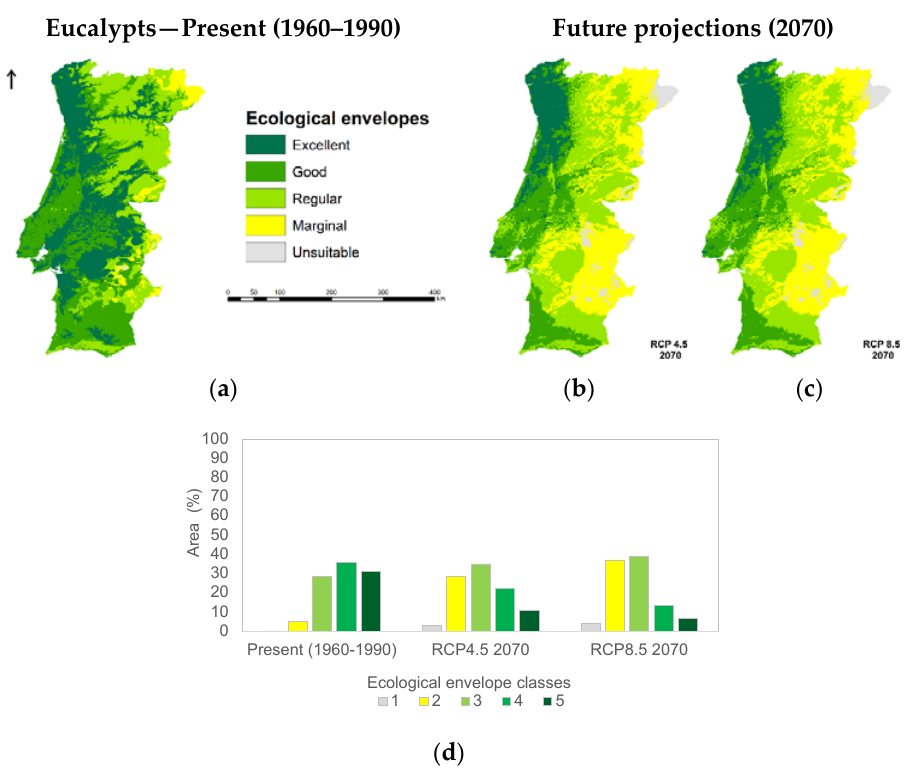
Figure A1. Species ecological envelopes: ( a ) Present (1960–1990); ( b ) Future RCP4.5 scenarios for 2070; ( c ) Future RCP8.5 scenarios for 2070; and ( d ) Ecological envelopes classes percentage areas distribution.